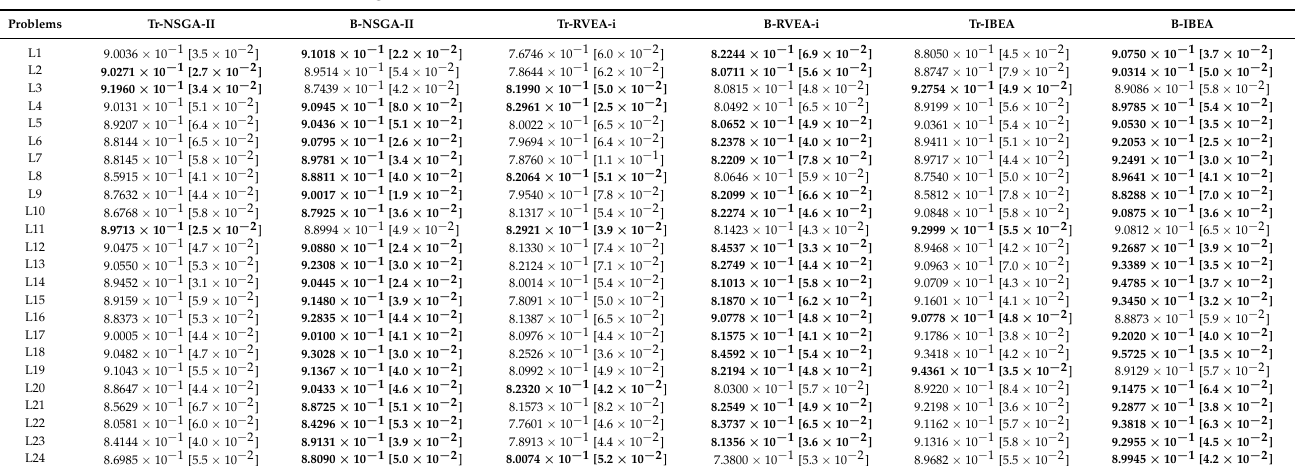
The better mean for each instance is highlighted in boldface. Table 9. Mean and standard deviation values of the MHV metric obtained by comparing algorithms for large-scale